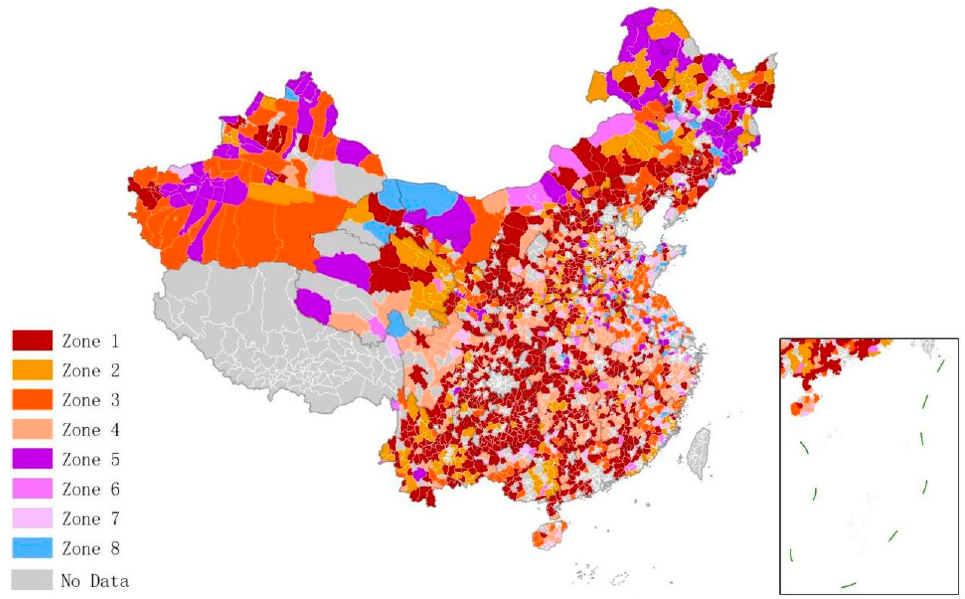
Figure 7. Differentiated governance zoning map of Chinese counties. Table 3. Differentiated governance paths for each governance zone of Chinese